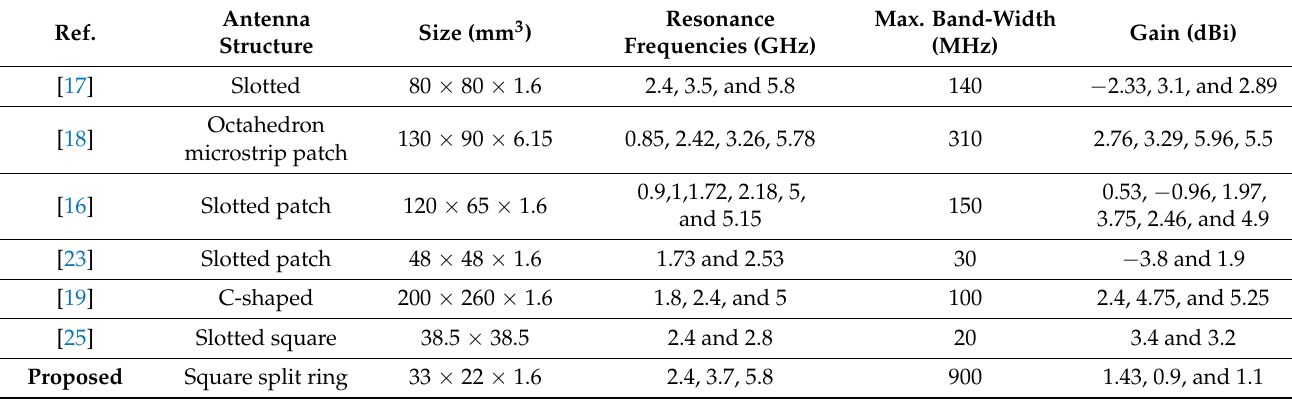
Table 4. Comparison of the proposed antenna with previous